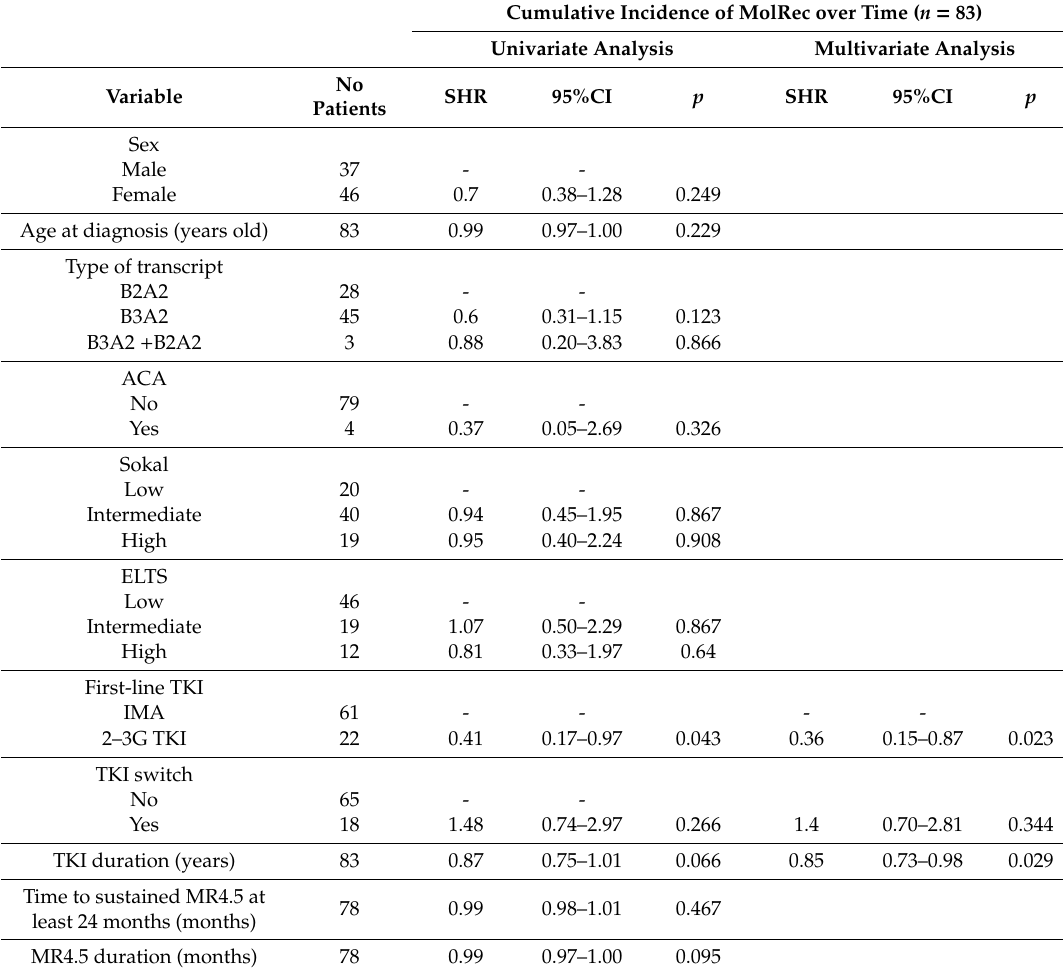
Table 4. Predictive factors of molecular recurrence after tyrosine kinase inhibitors discontinuation by univariate and multivariate Cox regression model analyses.